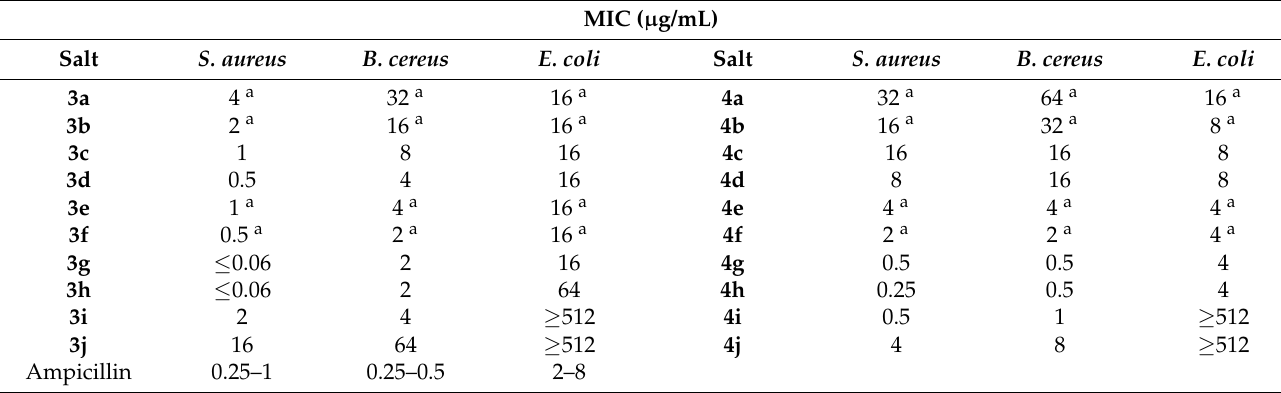
Table 2. Minimum inhibitory concentration (MIC) values of imidazolium salts against bacterial species.